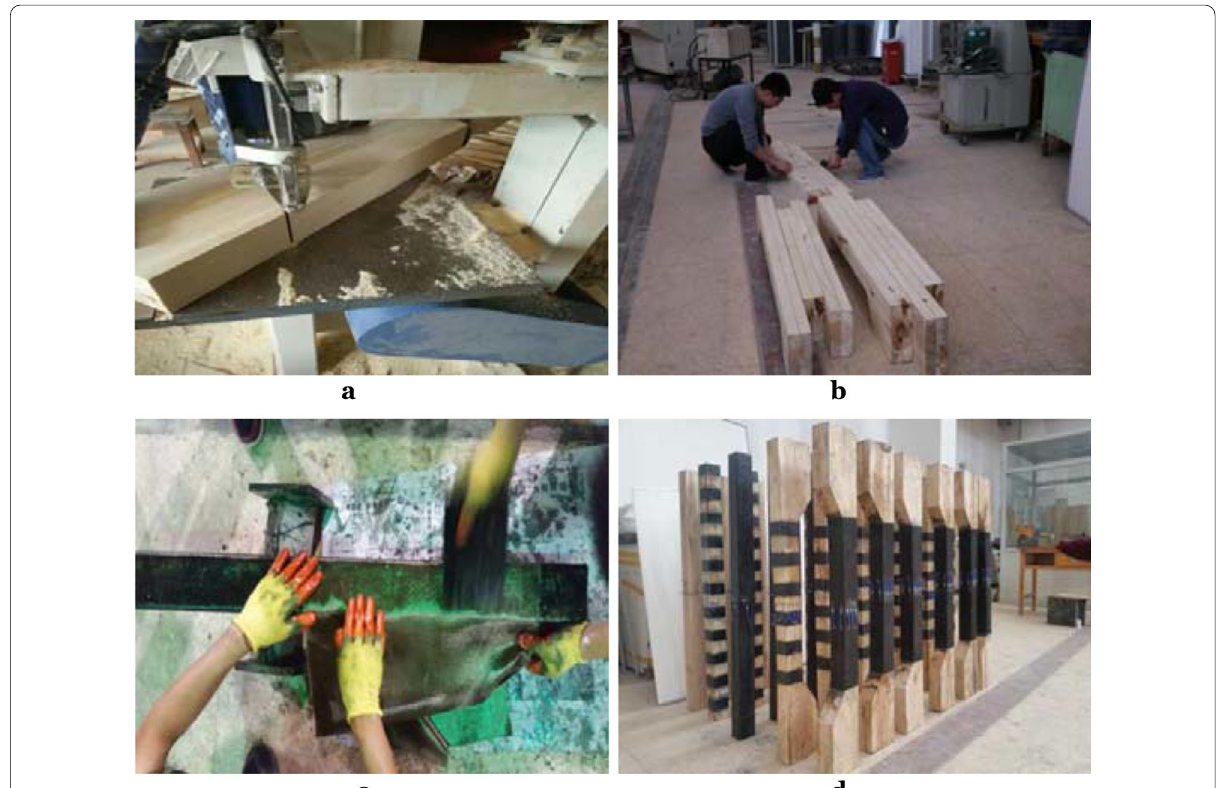
Fig.3 Main procedure of columns with strengthening BFRP: a processed wood, b underline, c primer and saturant painted, and d FRP bonded